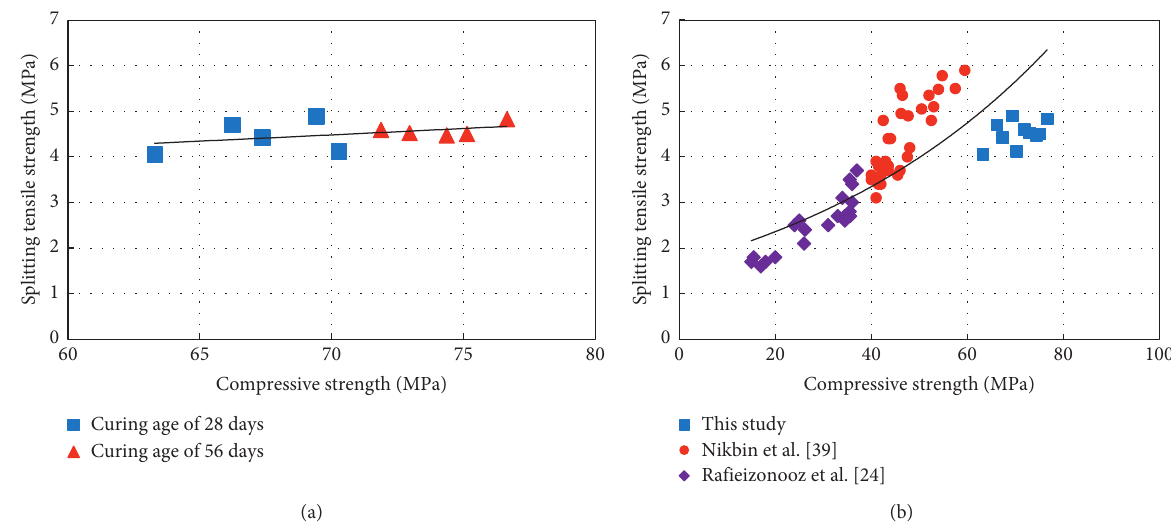
Figure 9: Relationship between the splitting tensile strength and compressive strength. (a) Test results in this study. (b) Test results in this study and previous studies.